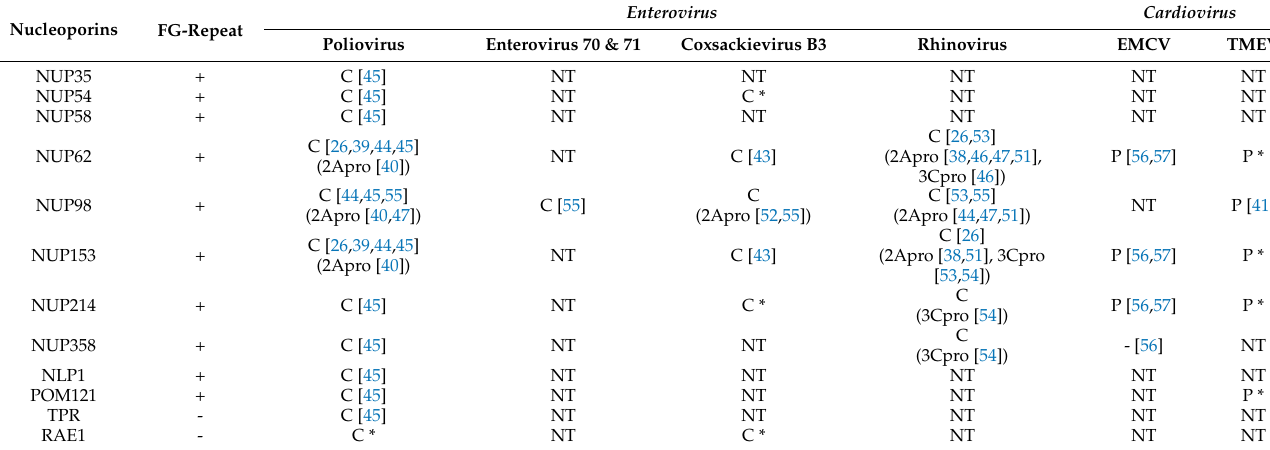
Table 1. Nucleoporins targeted by